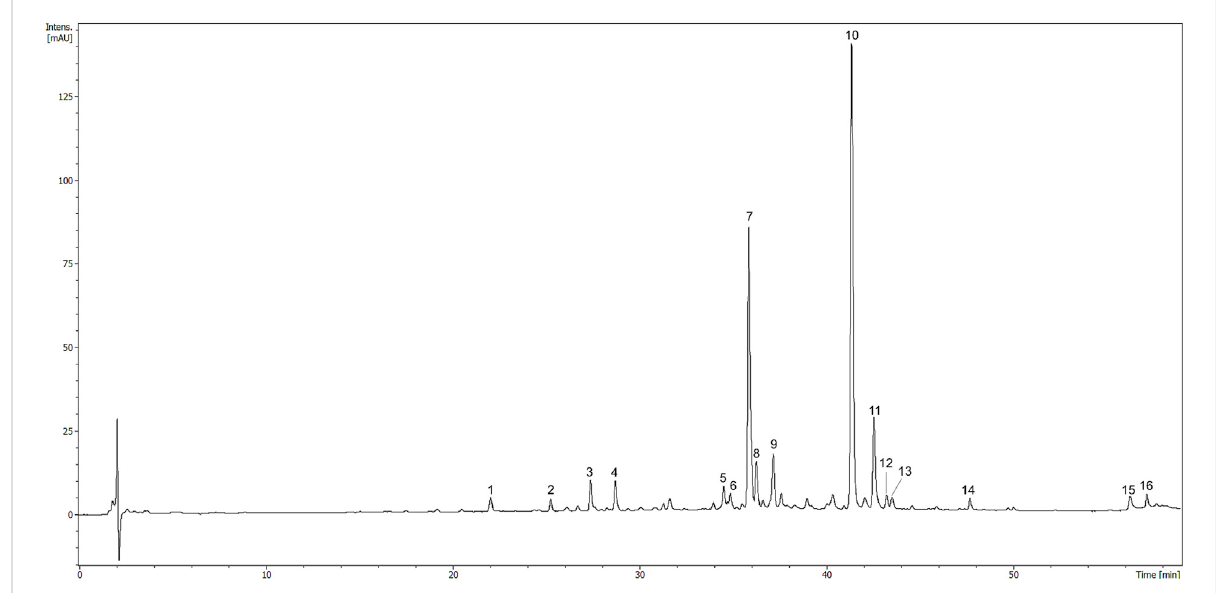
FIGURE 6 HPLC chromatogram of HR (10 mg/ml) registered at 325 nm. The number codes were provided in Table